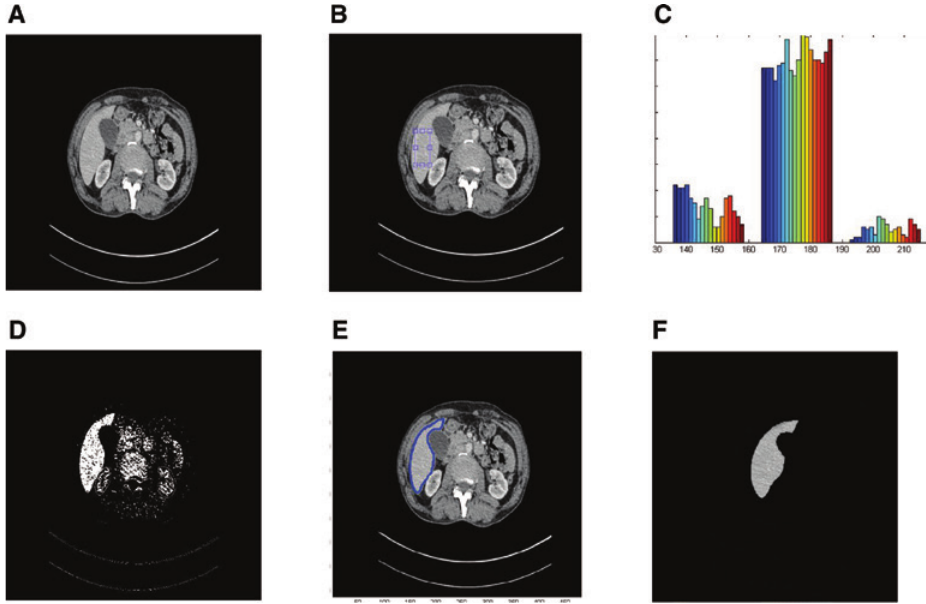
Figure 2: Illustration of liver extraction from CT scan using proposed method. (A) Original CT Scan Image. (B) Cropping Random Section of Liver. (C) Histogram of Cropped Liver Section. (D) Result of Histogram-Based Segmentation. (E) Liver Boundary in CT Scan. (F) Ground Truth